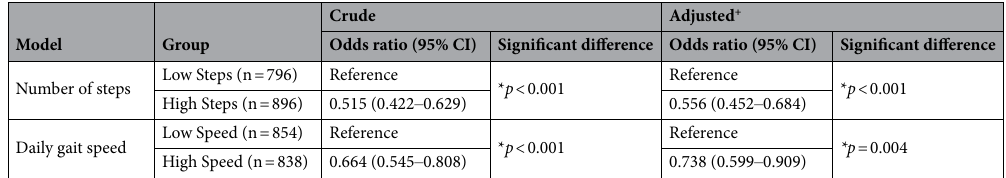
Table 3. Association of number of steps or daily gait speed with prefrailty in the binomial logistic regression models. + Adjusting variables were age, sex, and body mass index (BMI). CI, confidence interval; * p < 0.05. Low Steps: Participants with a number of steps of < 6342.2 steps/day. High Steps: Participants with a number of steps of ≥ 6342.2 steps/day. Low Speed: Participants with a daily gait speed of < 106.3 cm/s. High Speed: Participants with a daily gait speed of ≥ 106.3 cm/s.